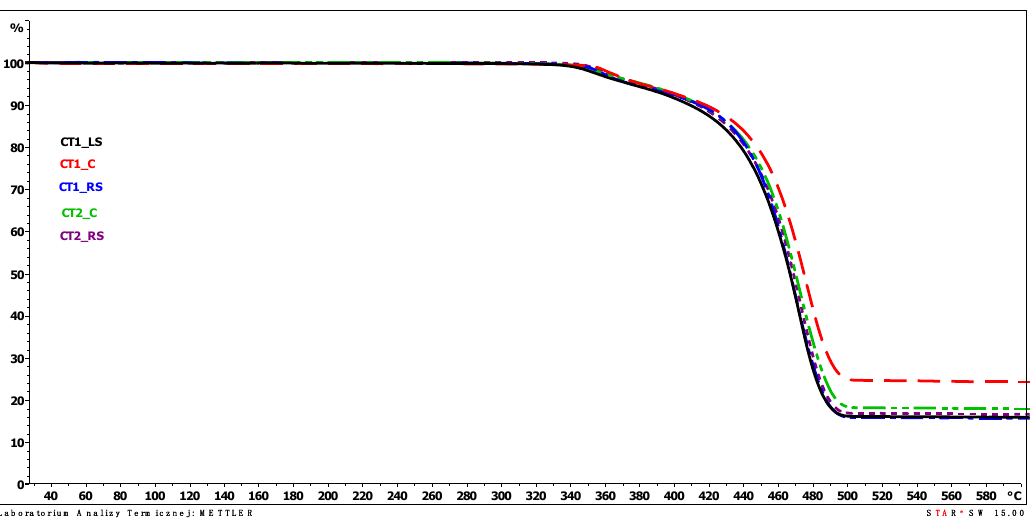
Figure 16. TGA curves of tested samples – temperature range from 25 to 600 °C.